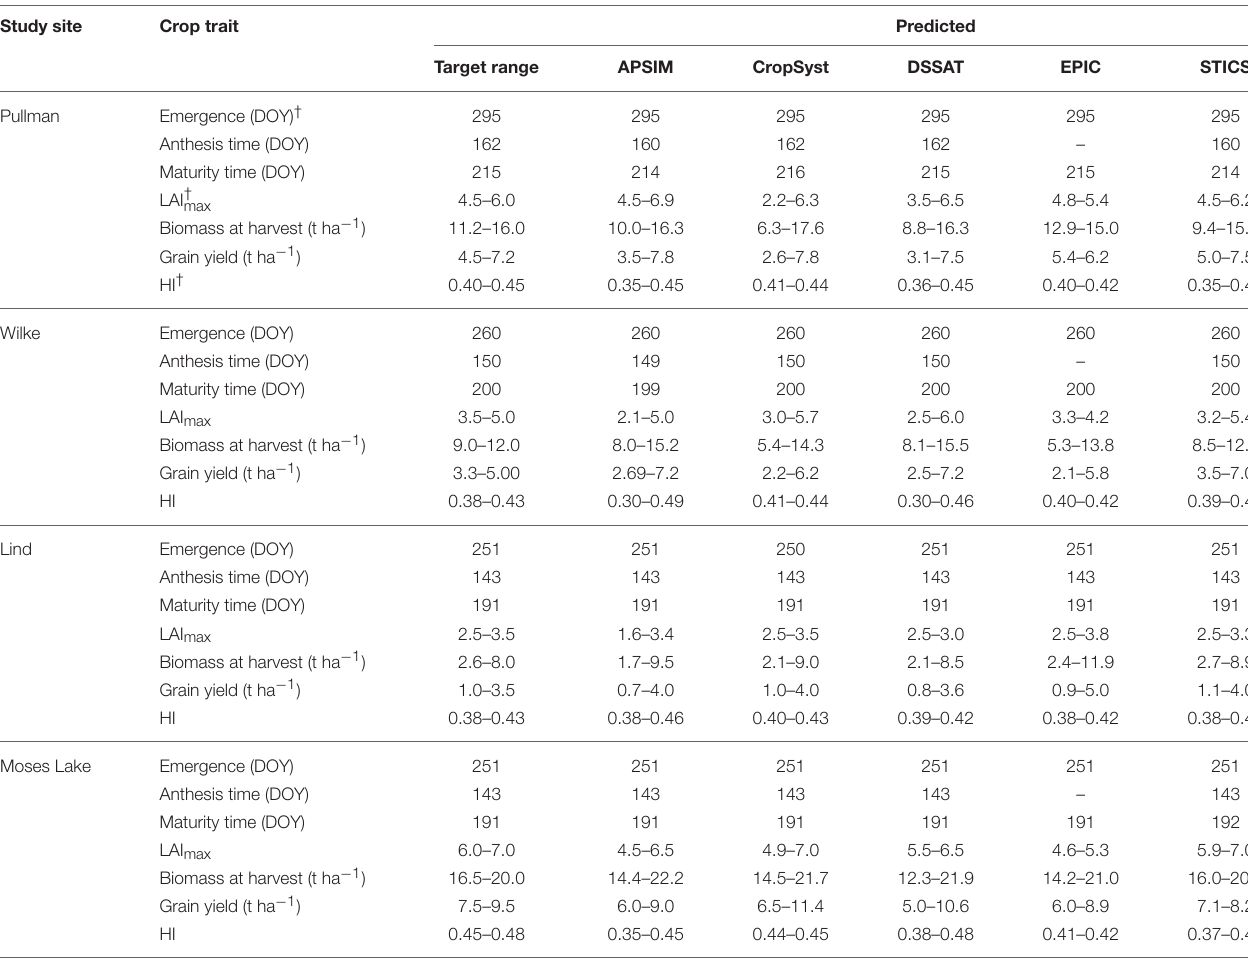
TABLE 4 | Target results for a series of five cropping system models used in a study of climate change effects on crop performance at several locations in the Pacific Northwest. Study